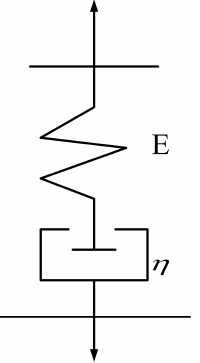
Figure 1. The Maxwell